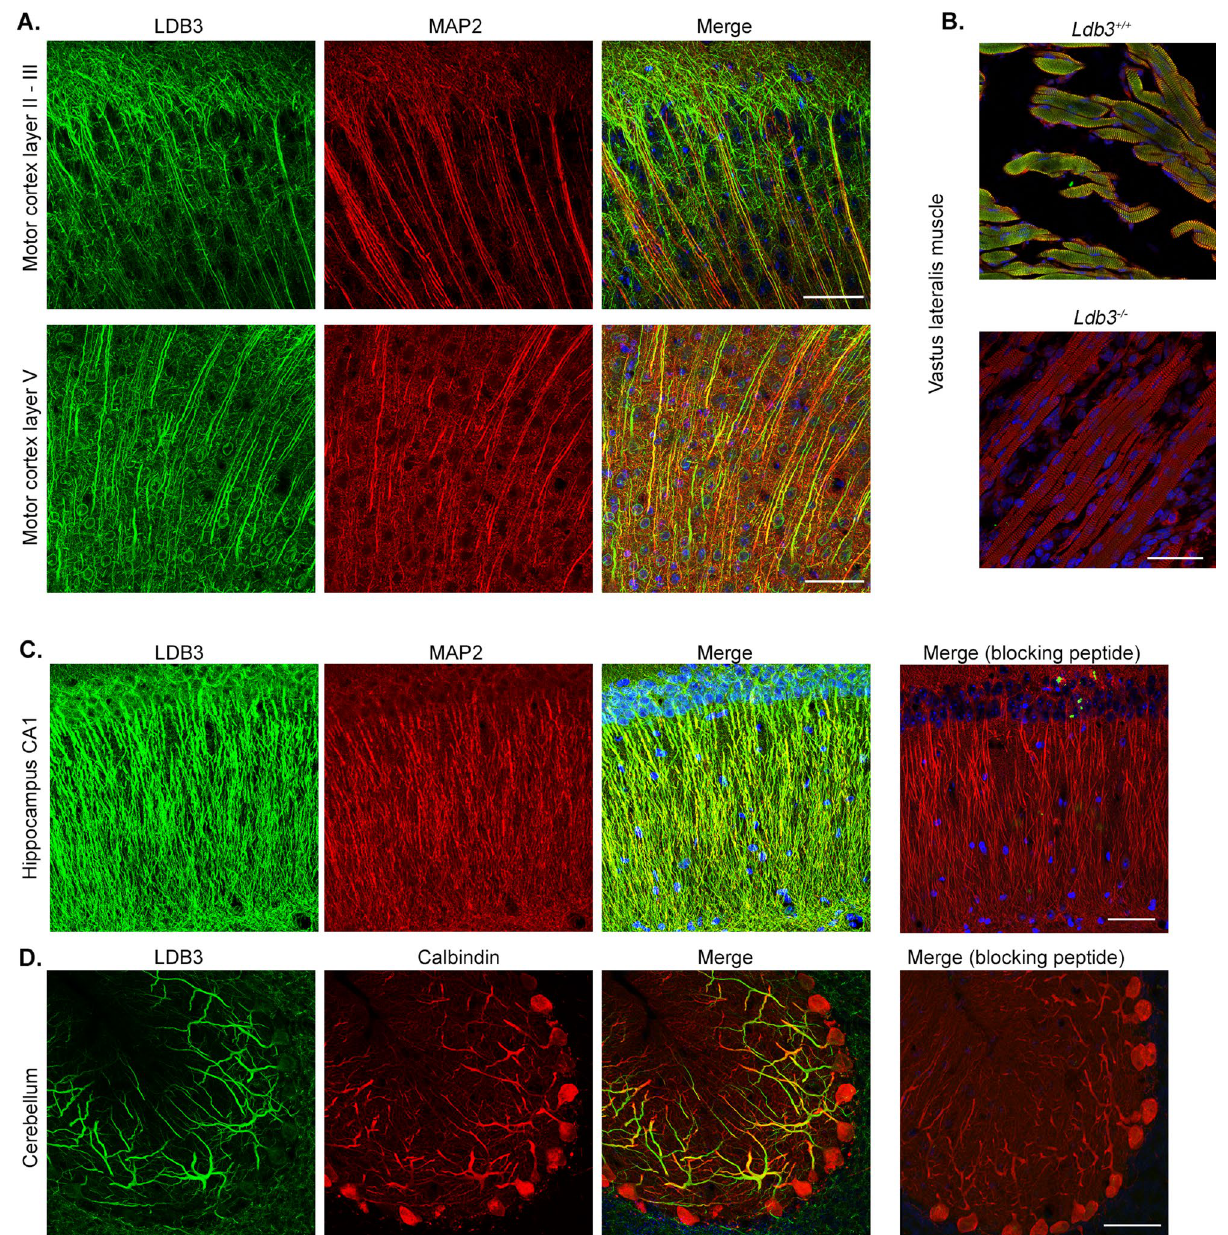
Figure 2. Immunolocalization of LDB3 in different regions of mouse brain. ( A ) Representative immunofluorescence using GTX115593 antibody on motor cortex coronal section shows LDB3 signal (green) in the apical dendrite bundles probably from layers III and V stained by MAP2 (red) and in thinner dendrites not labeled by MAP2 which are likely from superficial neurons in six-month old mice (n = 6). Bottom panel shows LDB3 signal (green) in MAP2 (red) stained cell body and dendrites of pyramidal neurons in motor cortex layer V in the same coronal section. ( B ) Representative immunofluroscence shows the same LDB3 antibody signal (green) co-localized with α-actinin-2 signal (red) at the Z-discs in the vastus lateralis muscle fibers of 18 day old Ldb3 + / + embryo but not Ldb3 −/− littermates (n = 3). Note Ldb3 −/− mice do not survive beyond birth. ( C , D ) Representative immunofluorescence using the same antibody shows LDB3 (green) in MAP2 (red) stained dendrites from the hippocampal CA1 neurons ( C ) and in calbindin (red) stained dendrites from the cerebellar Purkinje cells ( D ) in 6 month old mice (n = 6). LDB3 signal is absent in parallel sections incubated with LDB3 antibody plus a blocking peptide. Scale bar in all images 50